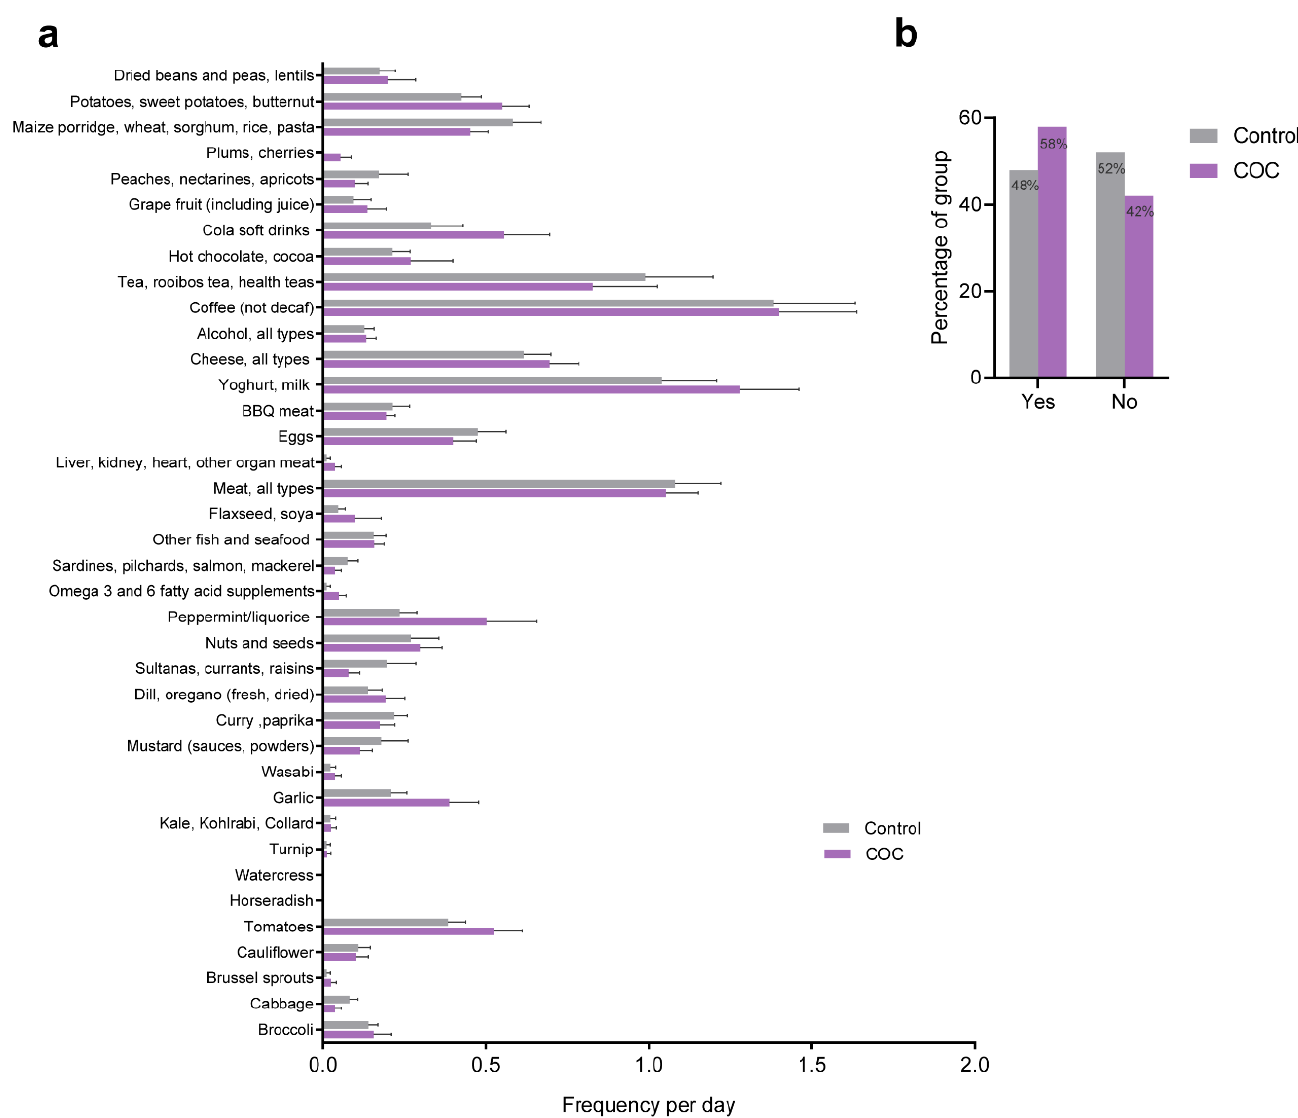
Figure 1. Dietary evaluation and nutritional supplement use. ( a ) The consumption frequency of specific food items per week was converted to an average frequency per day for statistical analysis. No correlations were found between any of the food items listed and either of the groups. ( b ) Proportion of participants that used nutritional supplements per group.